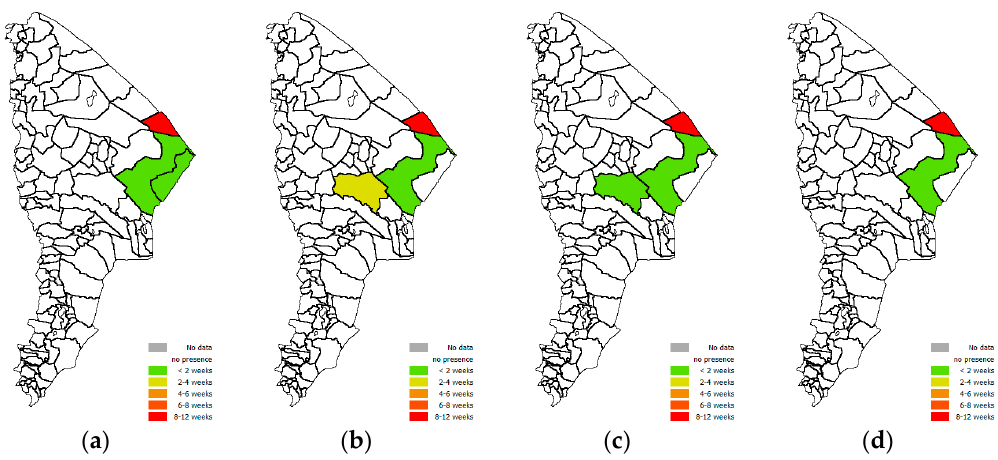
Figure 9. Wadijma sub-clan, Belig ( a ), Keremet ( b ), Bega ( c ) and Tsedaye ( d ) seasons (scale 1:9,900,000).